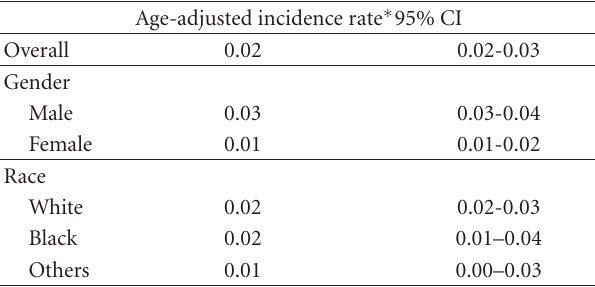
Table 1: Age adjusted incidence rate of sarcomatoid carcinoma (carcinosarcoma) of the urinary bladder per 100,000